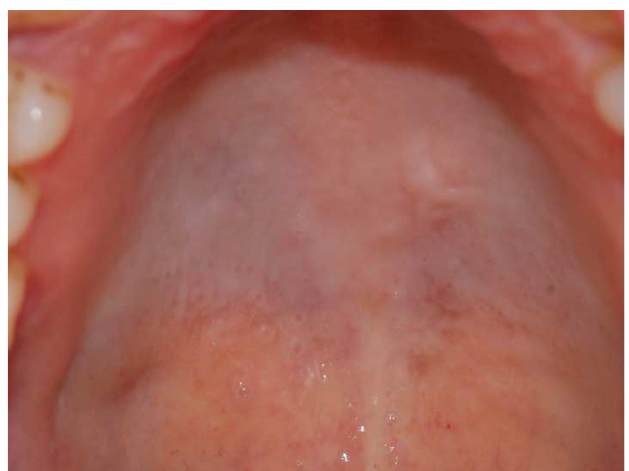
Fig. 5. Follow-up at 1 year. No recurrence. Fibrous scar tissue on the